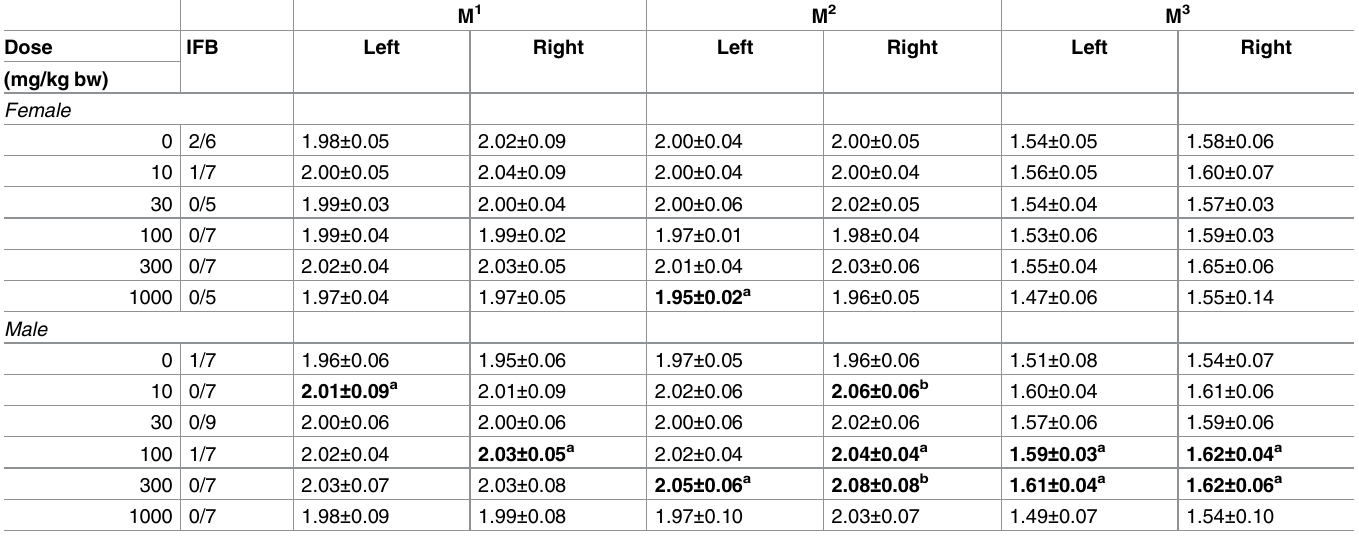
Table 5. Interfrontal bone frequency and maximum buccolingual diameter (mean ± SD, mm) for maxillary molar teeth in female and male offspring on PND 84 by total dose of PCB 180. M 1 M 2 M 3 Dose IFB Left Right Left Right Left